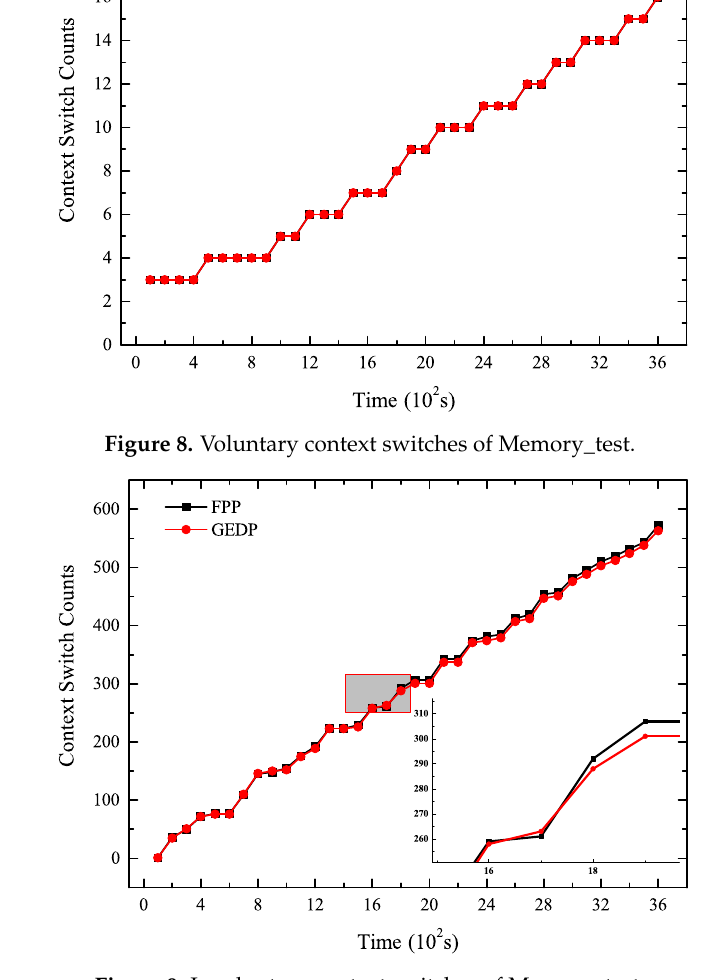
Figure 9. Involuntary context switches of